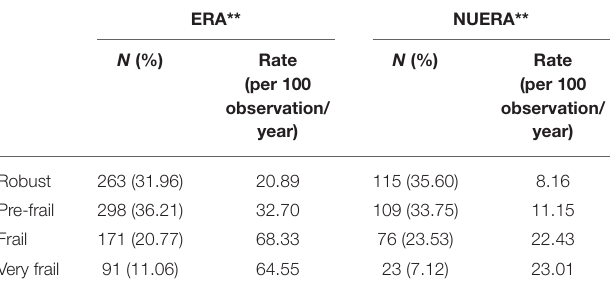
TABLE 2 | Prevalence of ERA ( N = 823) and NUERA ( N = 323), and one-way ANOVA of ERA and NUERA rate (per 100 observations/year), stratifies for frailty